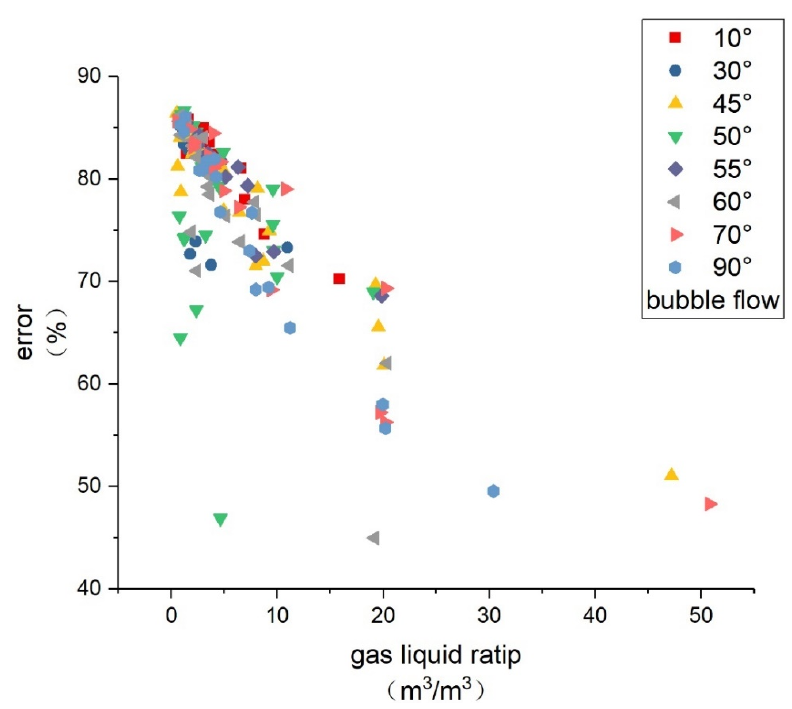
Figure 17. The error between calculated values and actual values in bubble flow. The Froude number (FR) is a dimensionless scalar in fluid mechanics; it is the ratio of the fluid kinetic energy to potential energy. When fr > 1, the water depth is small, and the velocity is turbulent. Similarly, when fr < 1, the velocity is slow, and the water depth is large. Similarly, the Reynolds number (Re) is also a classical dimensionless number used